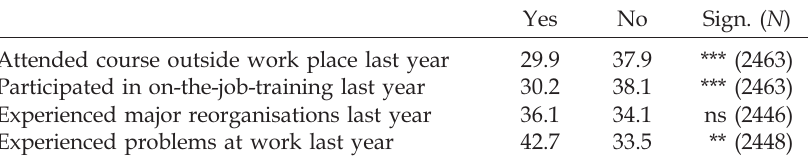
Table 6. Proportion experiencing declining work ability o v er the last ten years among employed persons aged 40 (cid:1) 69 years. Participation in courses or training and experience of reorganisations or problems at work. NorLAG. Percentage. ( N